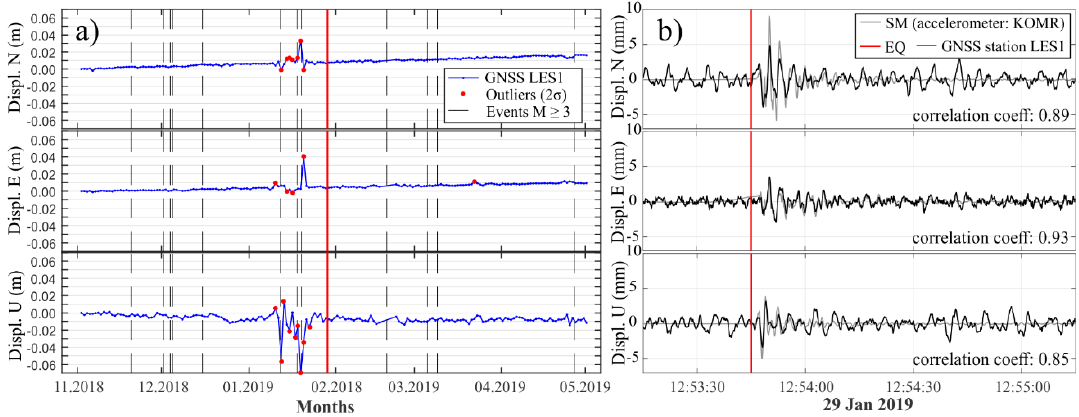
Figure 3. GNSS estimates in north, east, and up (top to bottom) components: ( a ) long-term daily coordinates estimates; ( b ) DD-GNSS and accelerometer displacement comparison. The red vertical line shows the moment of the roof collapse. The vertical dashed lines in ( a ) show that other earthquakes with a magnitude more than 3 happened in the radius of 5 km around the LES1 station.